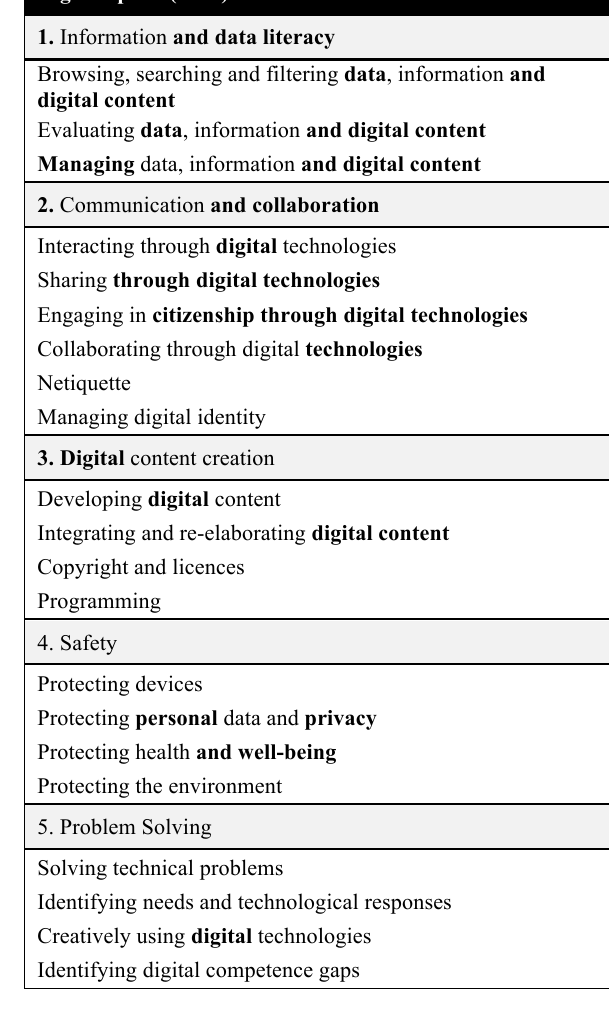
Table 2. Digital competence frameworks